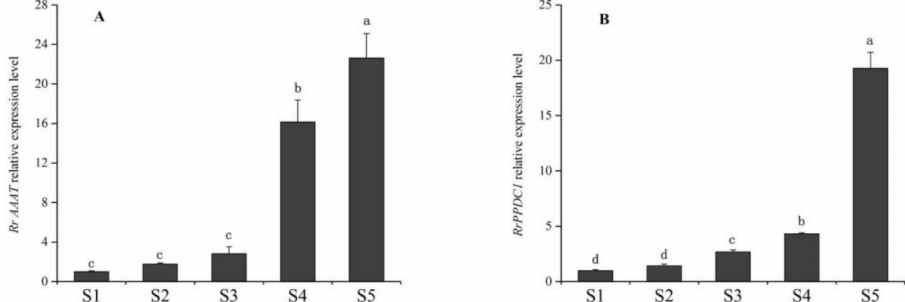
Figure 4. Quantification of gene expression levels in different stages of floral development of R. rugosa ‘Tanghong’ through real-time PCR. Values represent the means ± standard error (SE); Different letters (a, b, c) denote significant differences (Least Significant Difference (LSD) test, p ≤ 0.05). ( A ) relative expression level of RrAAAT gene; ( B ) relative expression level of RrPPDC1 gene; (S1) bud stage; (S2) early-open stage; (S3) half-open stage; (S4) full-open stage; (S5) decline stage.